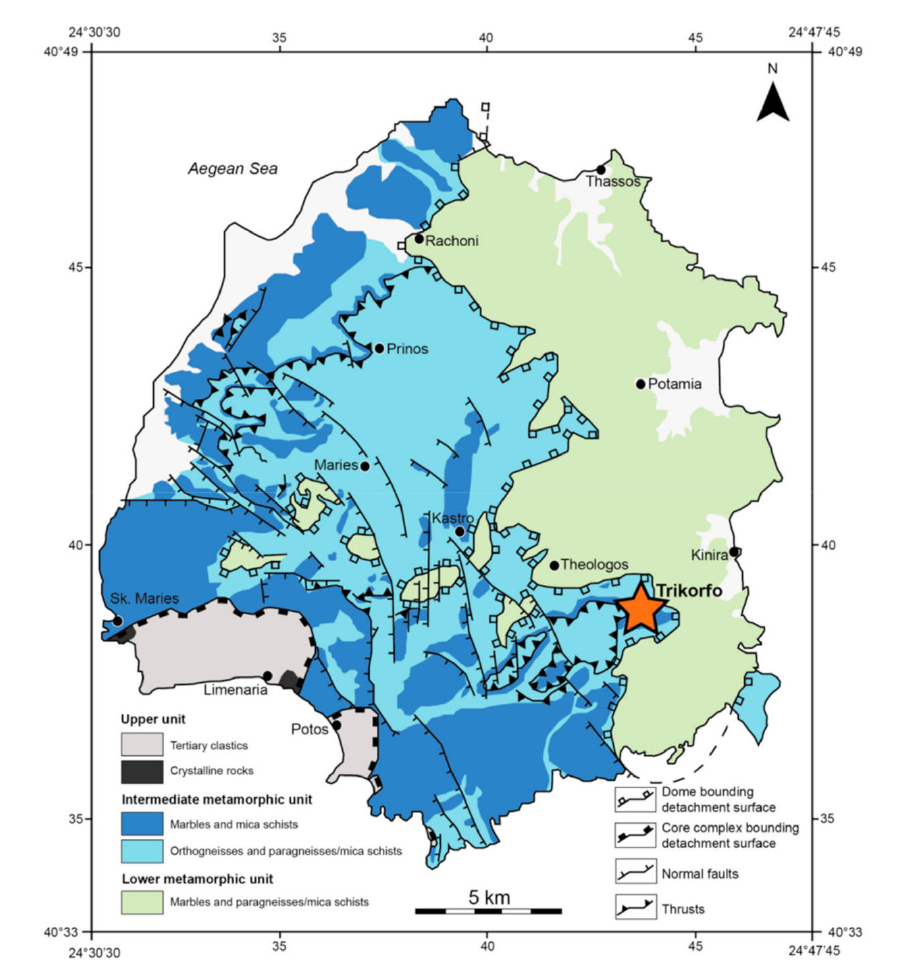
Figure 2. Geological map of Thassos Island with main units, modified from Wawrzenitz and Krohe [36] and Brun and Sokoutis [40]. The location of the Trikorfo area is indicated with an orange star. Thassos Island is represented by three main metamorphic units with, from base to top, (i) the lower metamorphic unit dominated by mylonitic marbles with intercalations of mica schists and paragneisses forming metamorphic domes to the east of the island, (ii) an intermediate metamorphic unit composed at the base of gneisses overlapped by marbles with paragneiss, mica schist and amphibolite intercalations, (iii) the upper unit is considered as the hanging wall, consisting of non-mylonitic metamorphic rocks dominated by gneisses, migmatites, pegmatites and locally ultramafic rocks and marbles [36,40]. Metamorphic rocks from the lower and intermediate units reached amphibolite